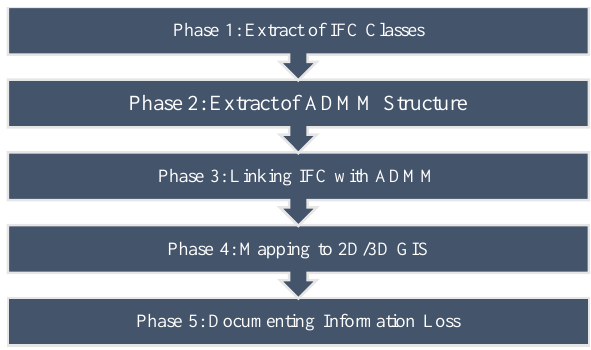
Figure 3 . The proposed method.